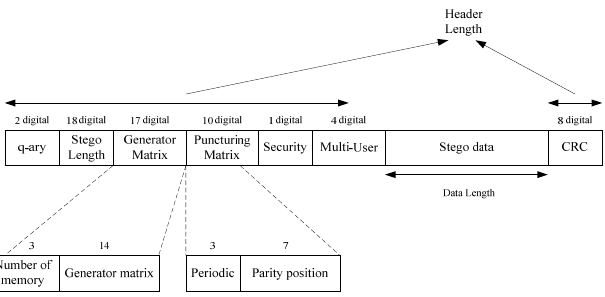
10 of 13 Figure 8. 7-ary, constraint length = 5, η = 5.56. Figure 9. 5-ary, constraint length = 3, η = 4.8. Figure 10. 5-ary, constraint length = 5, η = 5.1.